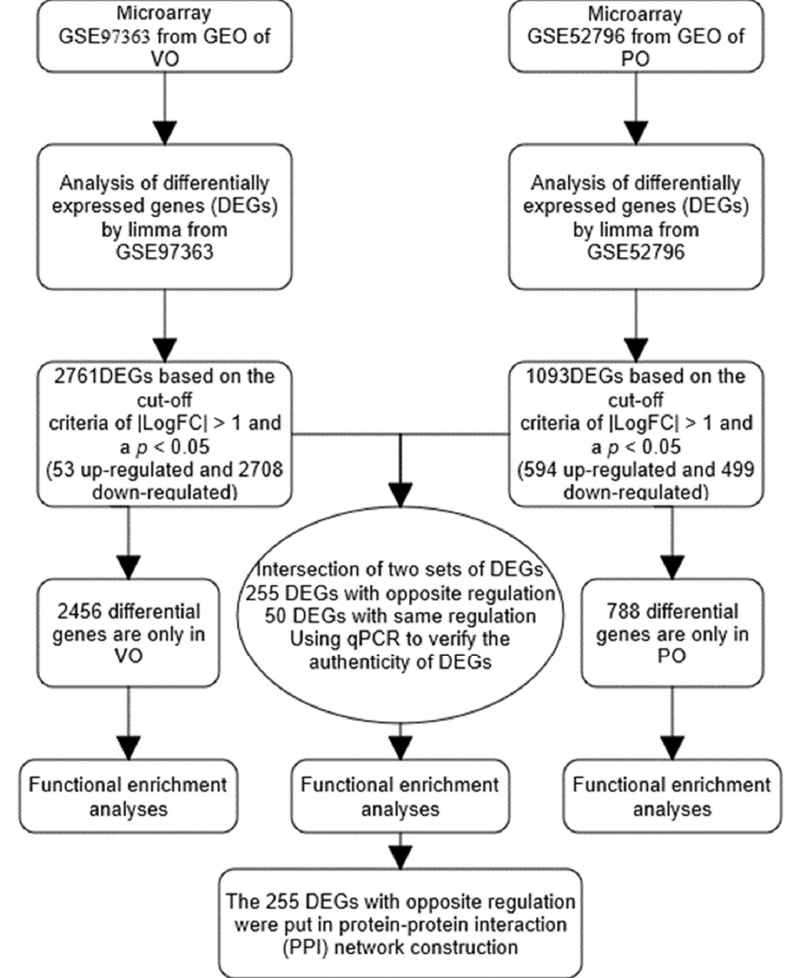
Figure 1. Flowchart of data analysis. VO: volume overload; PO: pressure overload.